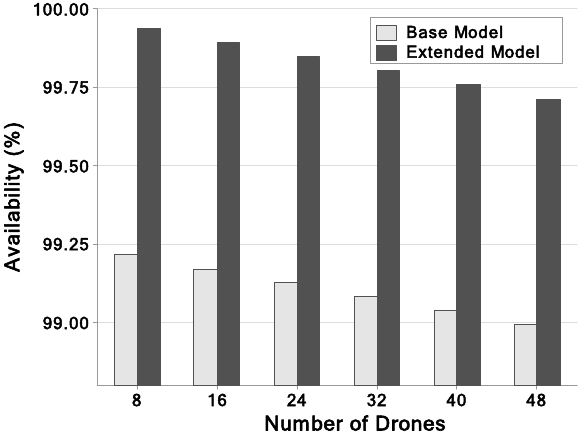
Figure 12. Availability according to the number of